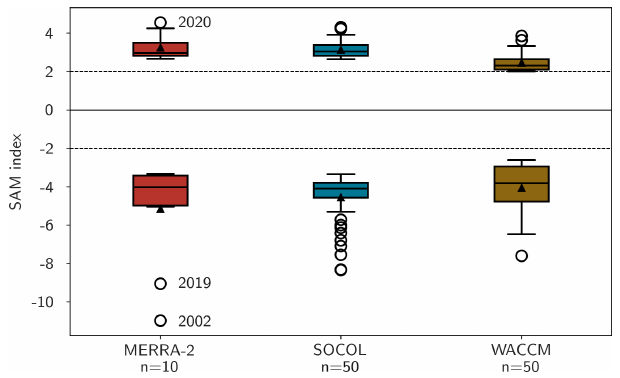
Figure 1. The 10hPa SAM index values of the lowest and high- est 25% of the springtime SAM indices in MERRA-2 (10 events per weak/strong category) and in the CCMs WACCM and SOCOL (50 events per weak/strong category). The most anomalous events in the observations are annotated with the year of